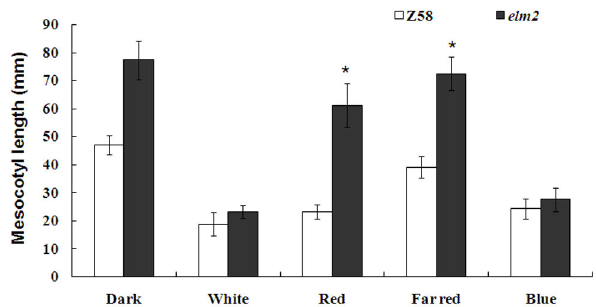
Figure 3. Statistical measurement of mesocotyl length in Zheng58 wild-type plants and elm2 mutant plants. Zheng58 wild-type seedlings and mutant elm2 seedlings were grown for 7 d in continuous darkness, white light, red light, far-red light, or blue light conditions. The sample size was 16-18 seedlings per treatment/genotype. Asterisk indicates significant difference as compared with Zheng58 wild- type at P <0.01 (Student’s t test).